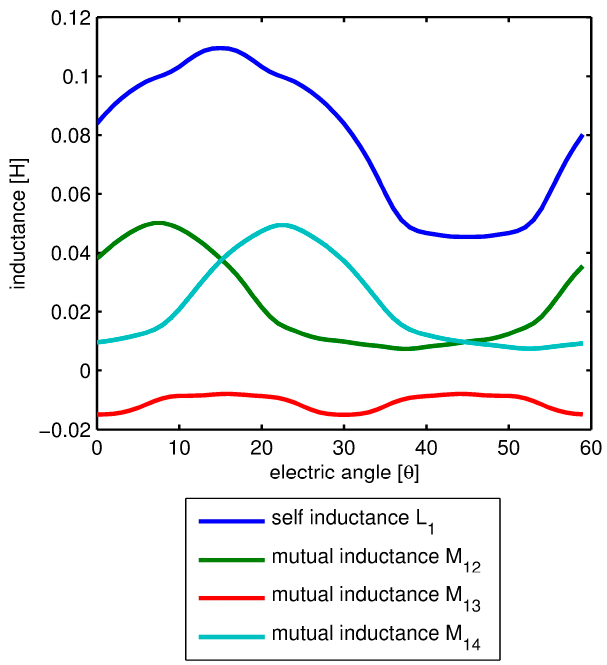
Figure 3. The motor inductance waveforms for each phase. Energies 2017 , 10 , 799